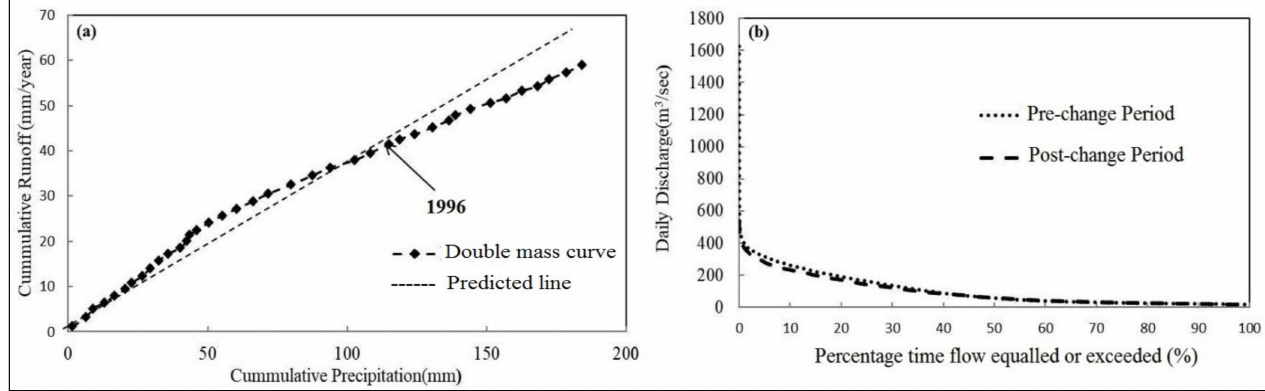
Figure 10. The determination of abrupt change in a time series using ( a ) a double mass curve and; ( b ) a flow duration curve